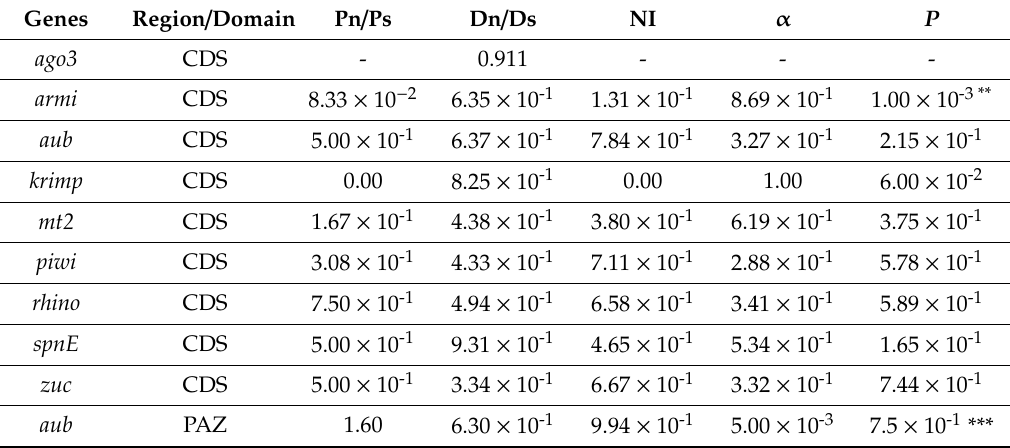
Table 2. Results of McDonald and Kreitman (MK) test comparing D. buzzatii and D. koepferae sequences. Genes Region / Domain Pn /